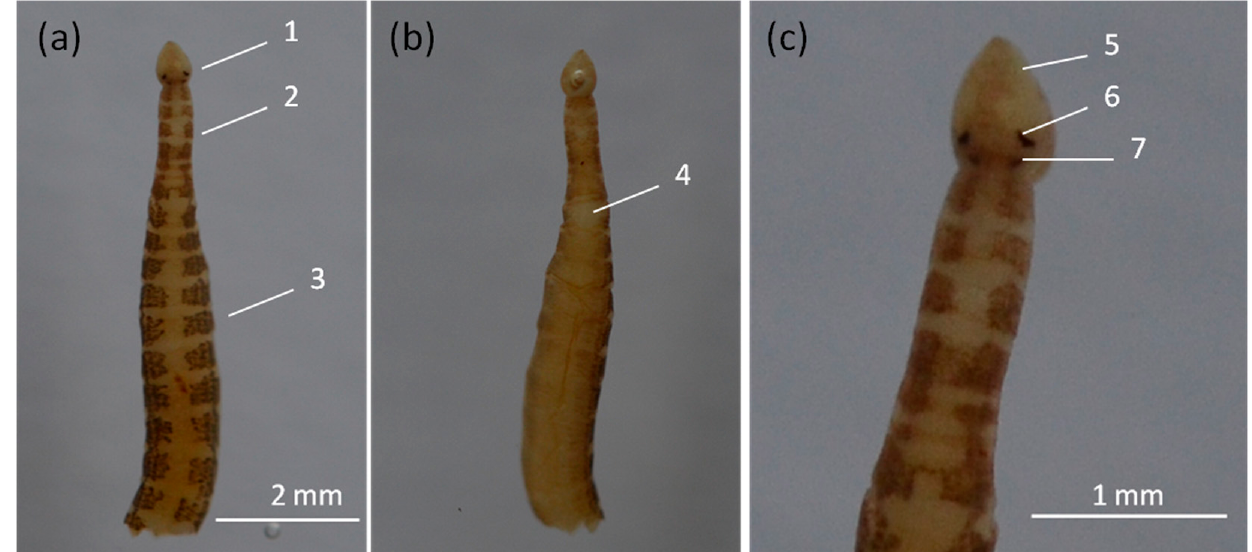
Figure 4. Morphology of Piscicola nordica sp. nov.: ( a ) dorsal view, ( b ) ventral view and ( c ) anterior part of body. Numerical designations: 1—oral sucker, 2—trachelosome, 3—urosome, 4—copulatory area, 5—depigmented area, 6— crescentiform eye and 7— baculiform eye .